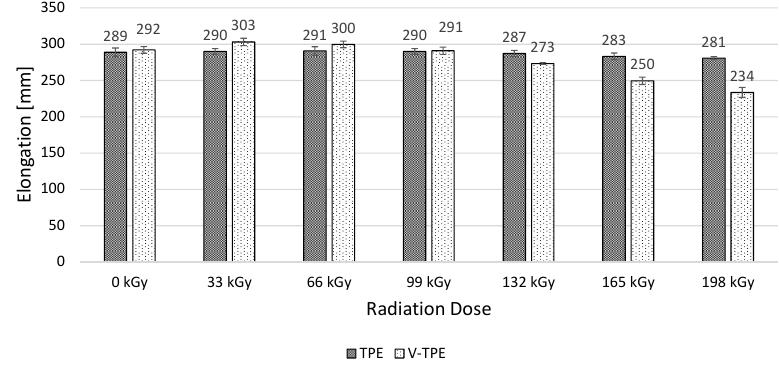
Figure 17. Tensile impact elongation—TPE,